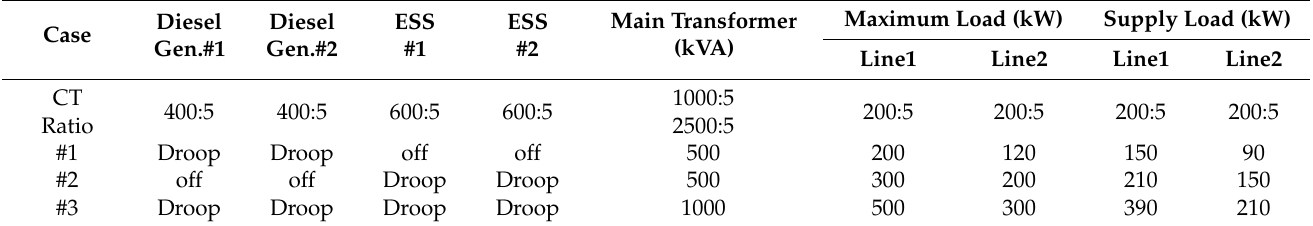
Table 3. % Impedance of generation sources and pieces of equipment [36].